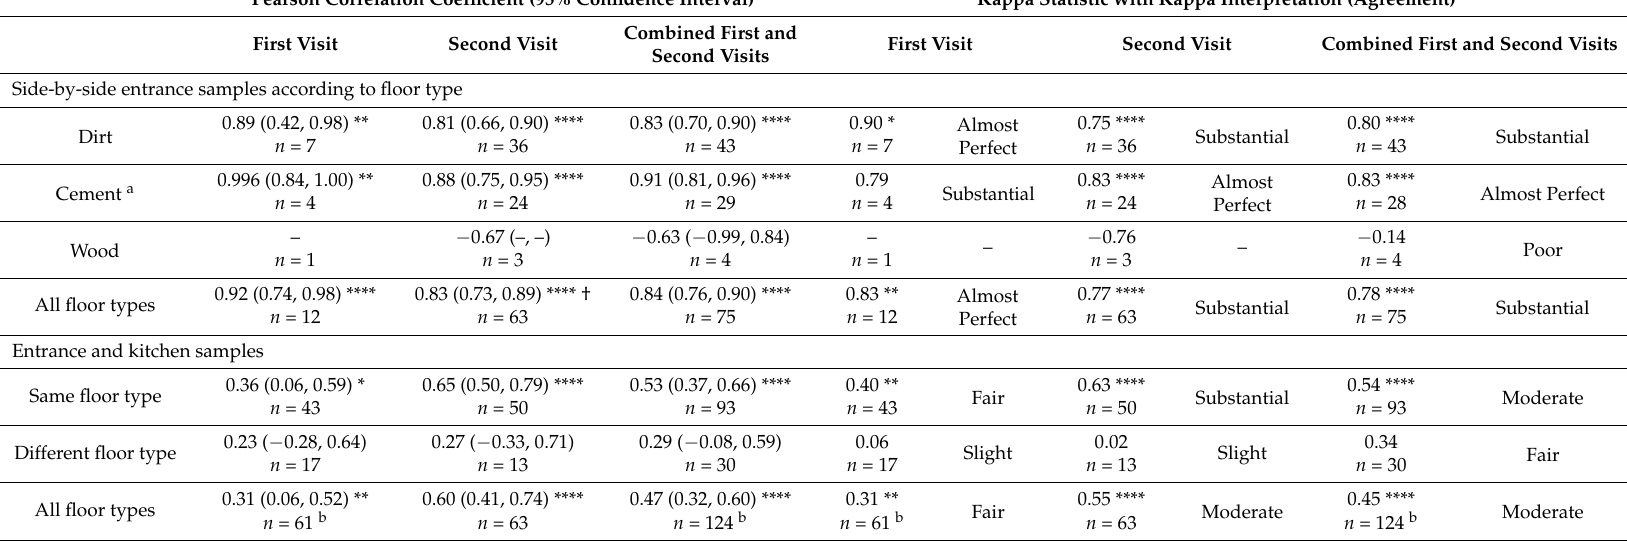
Table 1. Spatial sampling agreement of E. coli with the dry cloth method—distribution within